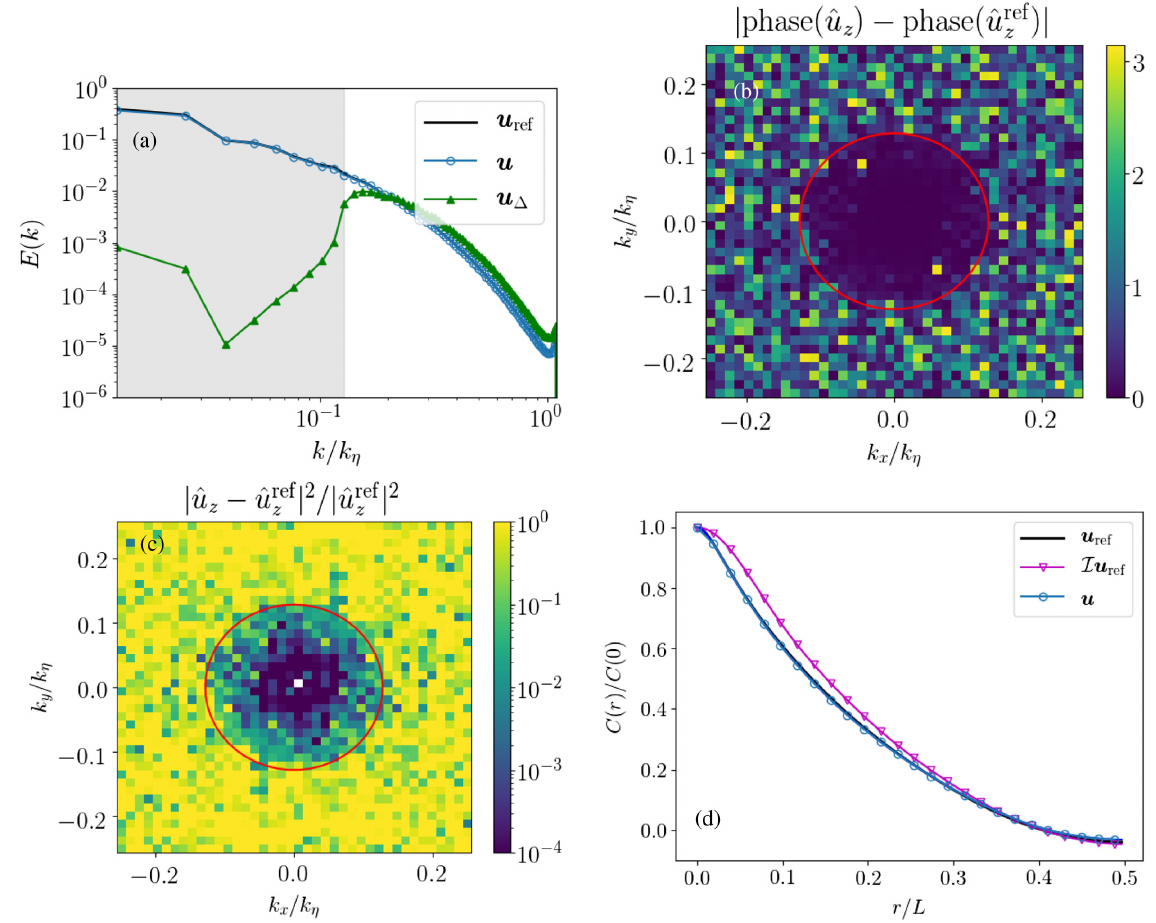
FIG. 7. (a) Energy spectra for the nudged u , the reference u k < k n . (b) Point-by-point error between the phases of the nudged field and the reference one in the as for (b) but for the normalized amplitudes of the z component. The red circle defines k n . (d) Two-point correlation